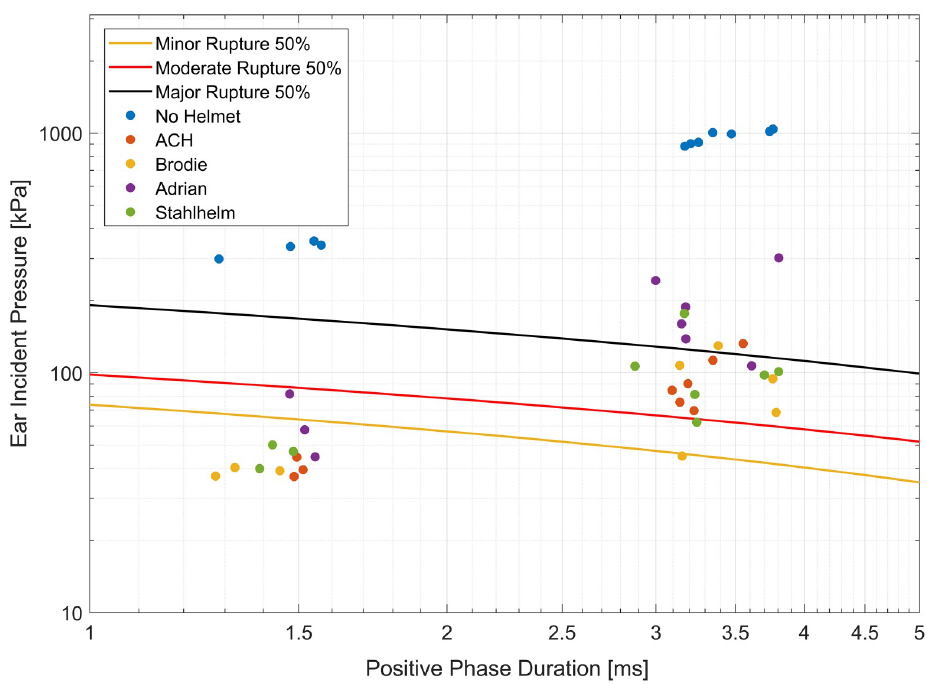
Fig 12. Helmets reduce the risk of eardrum rupture. Measured peak incident pressures at the ear and eardrum rupture risk curves from Richmond et al. [33]. Risk of eardrum rupture is lower in all helmeted cases compared to the bare head, and is higher in the French Adrian helmet compared to other tested